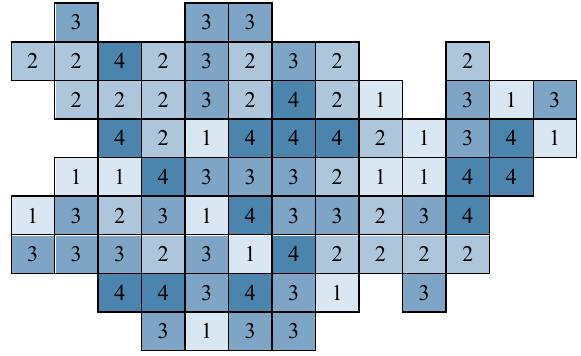
Figure 9. Optimal technological model of coal deposit for a (78 × 6) matrix.